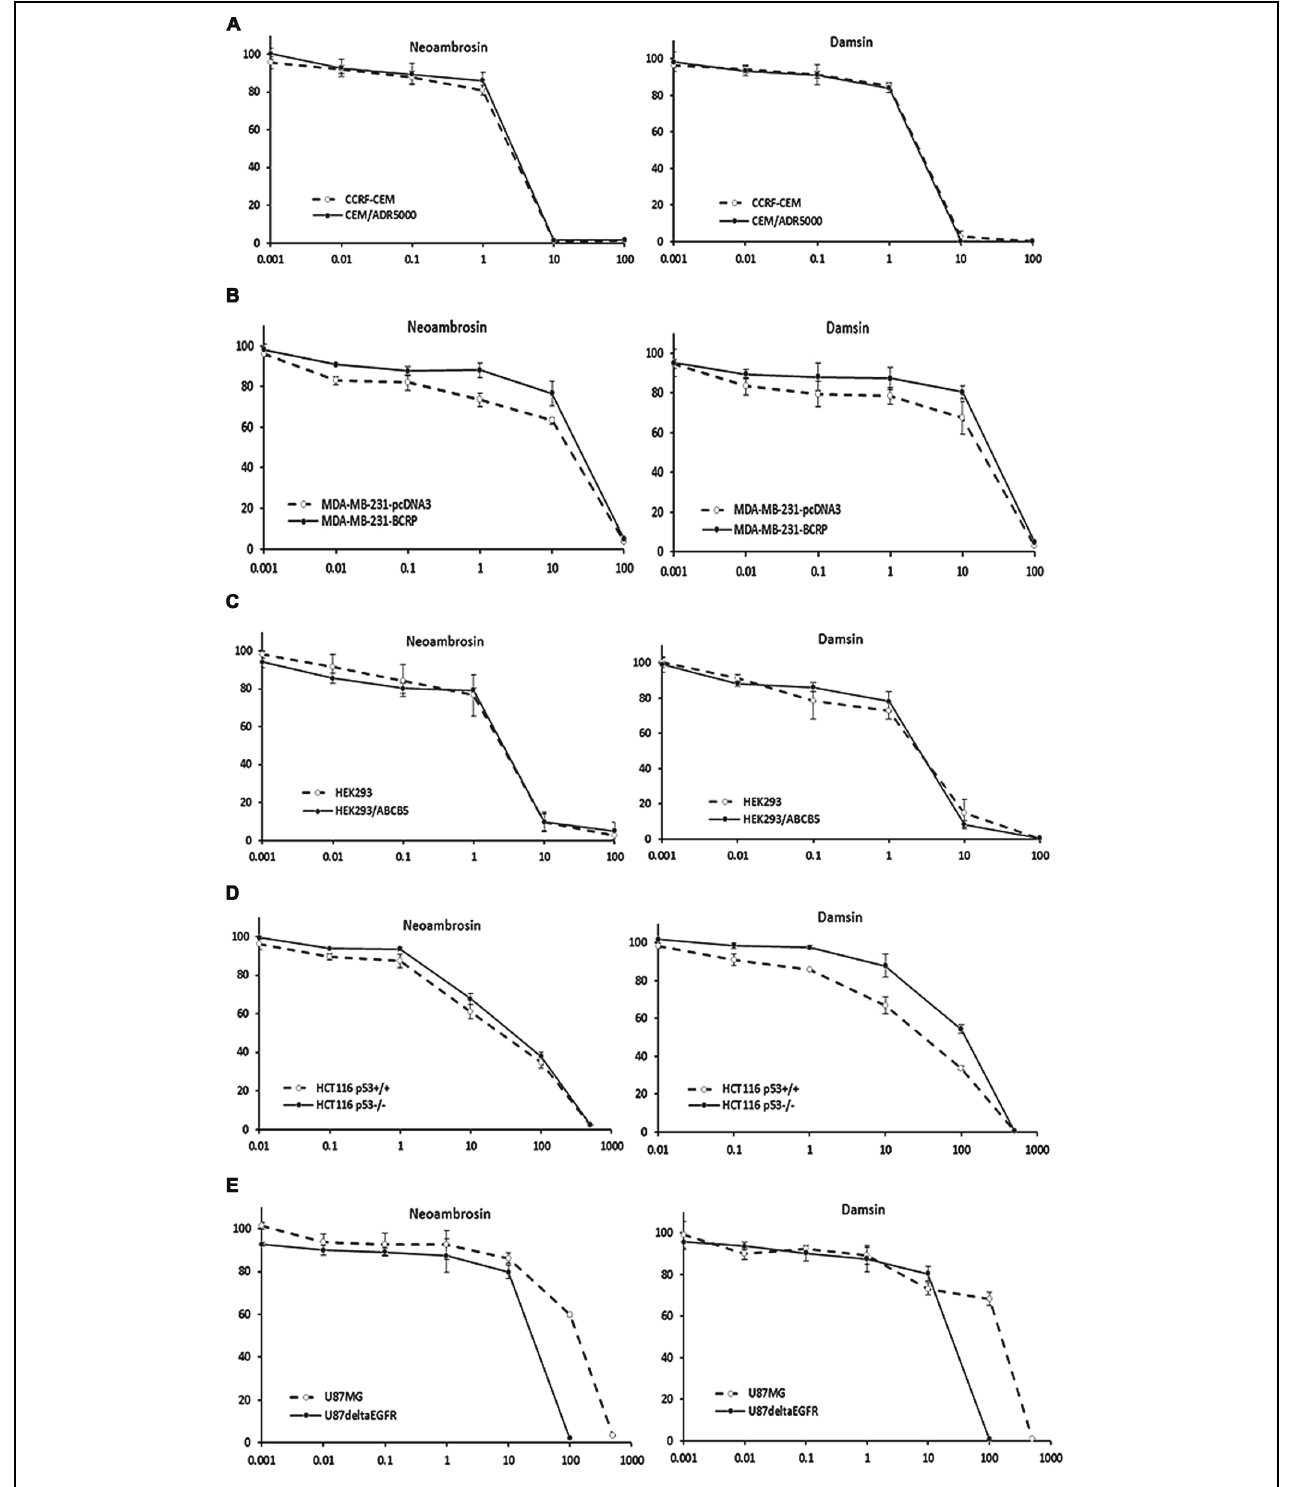
FIGURE 2 | Dose response curves of neoambrosin (1) and damsin (2) as determined by resazurin assays. (A) Cytotoxicity against drug-sensitive parental CCRF-CEM tumor cells and their P -glycoprotein ( P -gp; MDR1/ABCB1 )-expressing, multidrug-resistant subline, CEM/ADR5000. (B) Cytotoxicity against MDA-MB-231-pc DNA cells and their BCRP-transduced subline, MDA-MB-231-BCRP. (C) Cytotoxicity against HEK293 cells and their ABCB5 -transfectant subline, HEK293/ABCB5. (D) Cytotoxicity against HCT116 cells (p53 + / + ) and their knockout subline (p53 − / − ). (E) Cytotoxicity against U87MG cells and their EGFR- transduced subline, U87MG (cid:2) EGFR. The dose response curves show mean values ± SD of three independent experiments with each six parallel measurements.